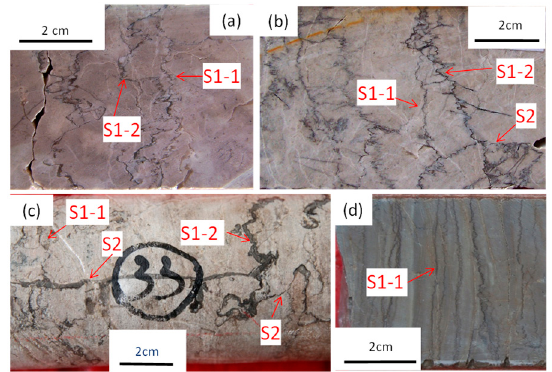
Figure 5. Photographs showing stylolites in cores. ( a ) Bedding-parallel, low-amplitude stylolite (S1-1) and high-amplitude stylolite (S1-2), H601-1, 6633.28 m; ( b ) oblique stylolite (S1-2) merged into bedding-parallel stylolite (S1-1), tectonic stylolite (S2) terminated in the oblique stylolite (S1-2), H902, 6641.61 m; ( c ) tectonic stylolite (S2) cross-cutting S1-1 stylolites and terminated in S1-2 stylolites; dissolution and enlargement along S1-2 and S2 stylolites in a fault damage zone, R4, 6625 m; ( d ) bedding-parallel stylolites (S1-1) in mudstone in country rocks, H6, 7044.21